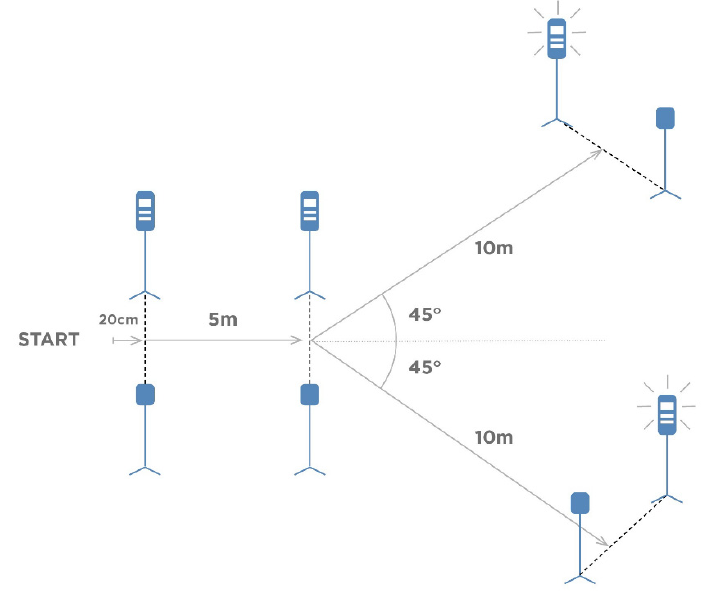
Figure 1. The layout of the photocell timing gates and the way of carrying out the test task protocol 1-1-2.